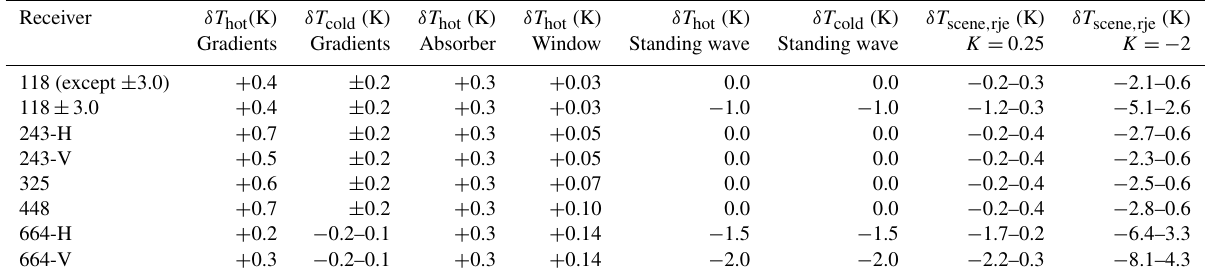
Table 2. Maximum typical calibration target temperature bias estimates and associated scene temperature biases during high-altitude flight. Receiver δT hot (K) δT cold (K) δT hot (K) δT hot (K) δT hot (K) δT cold (K) δT scene , rje (K) δT scene , rje (K) Gradients Gradients Absorber Window Standing wave Standing wave K = 0 . 25 K = − 2 118 (except ± 3.0) + 0.4 ± 0.2 + 0.3 + 0.03 0.0 0.0 118 ± 3.0 + 0.4 ± 0.2 + 0.3 + 0.03 243-H + 0.7 ± 0.2 + 0.3 243-V + 0.5 ± 0.2 + 0.3 + 0.2 + 0.3 +